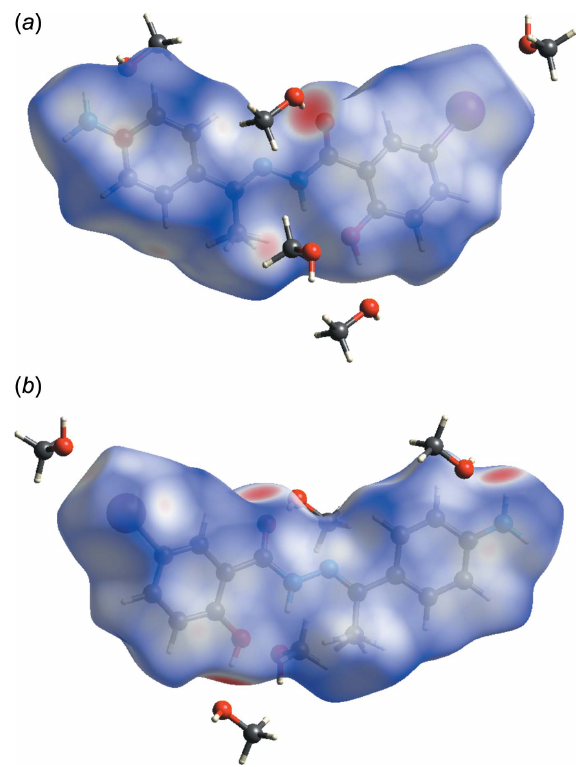
Figure 5 Views of the Hirshfeld surface for the title compound mapped over d norm over the range (cid:4) 0.740 to 1.296 a.u. showing the closest methanol